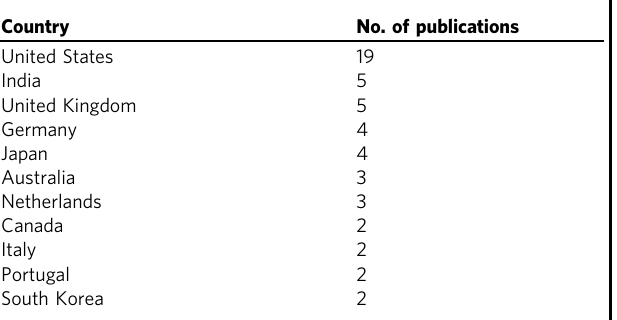
Table 2 Top countries of origin of the articles from the social science area